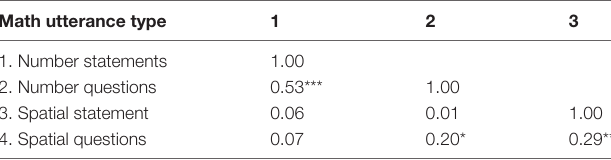
TABLE 7 | Pair-wise correlations among math utterance type